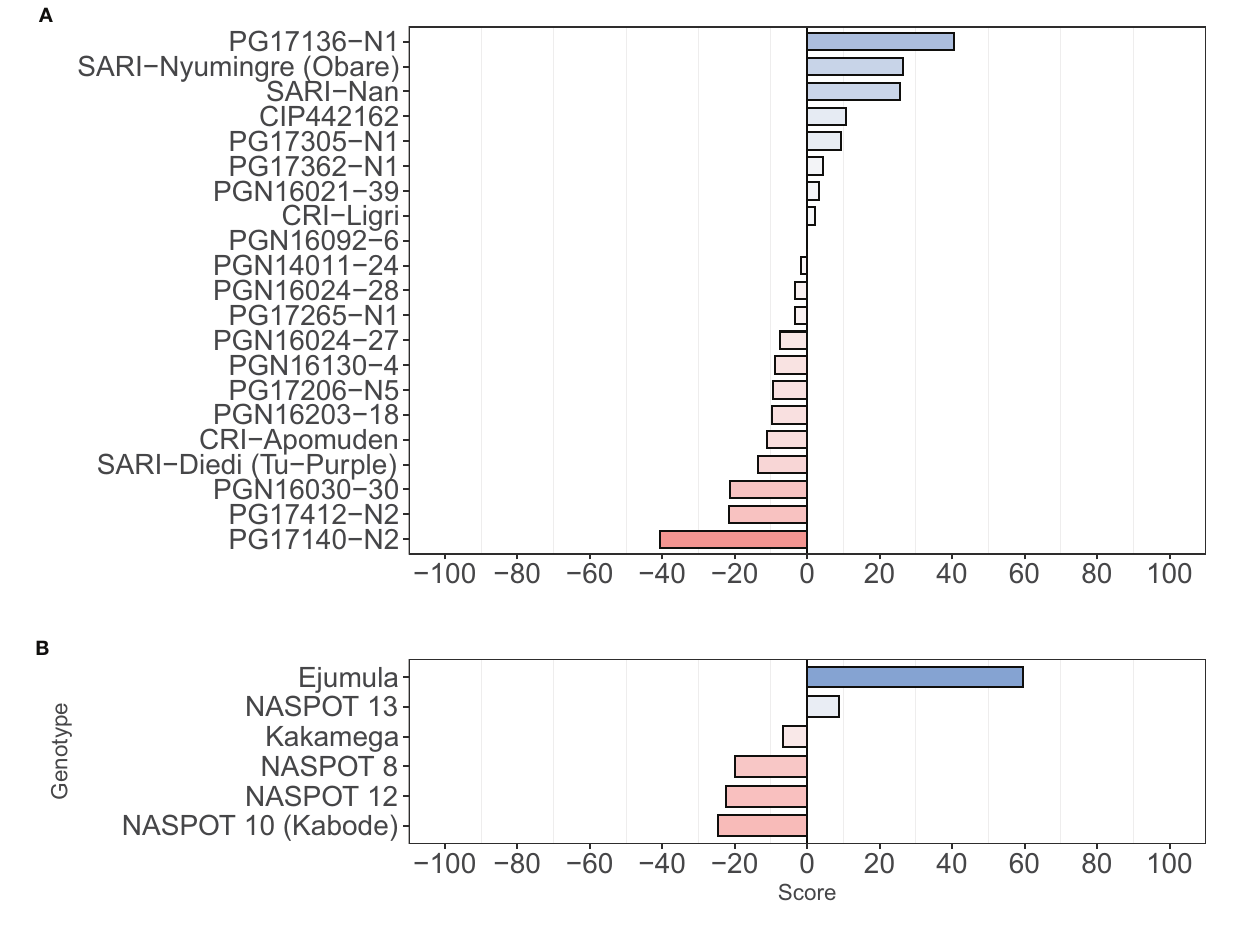
FIGURE 3 | Favourability score for the genotypes evaluated in (A) Ghana and (B) Uganda. Score is based on the relative number of times a given genotype is preferred over the others in pairwise contests in both home and centralized tasting